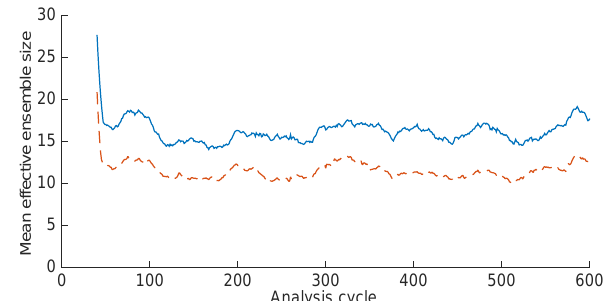
Figure 9. Illustrating the impact of ensemble space smoothing on the effective ensemble size N eff . Here, we show the 40-cycle mov- ing average of N eff for the smoothed (solid blue) and non-smoothed (dashed red)